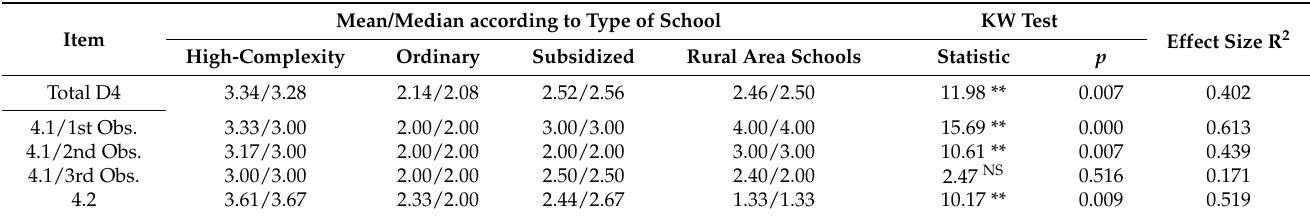
Table 5. Difference in means. Comparison of the difference in the variables from Dimension 2: Transi- tions at recess, as a function of the type of school. ( n = 23).